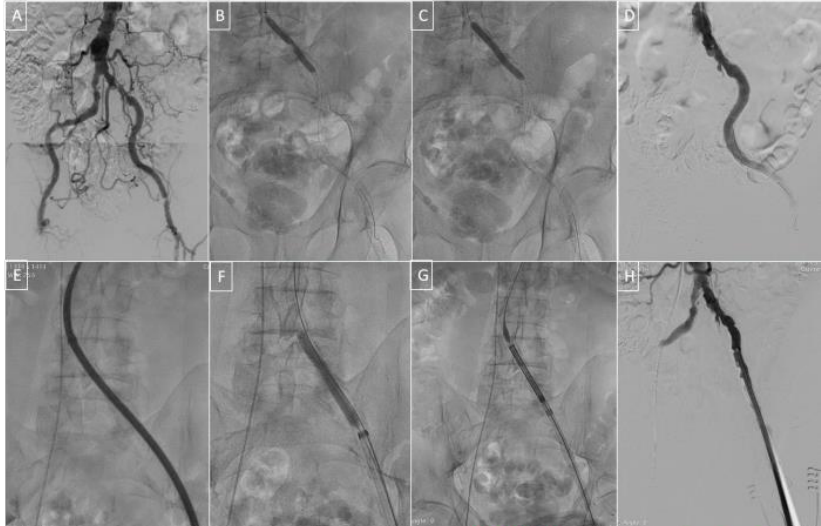
Figure 2. Intravascular lithotripsy (IVL) to facilitate TAVI (transcatheter aortic valve implantation) transfemoral access in a 79-years-old patient with severe aortic stenosis and end-stage chronic kidney disease on haemodialysis, arterial hypertension and diffuse peripheral arterial disease with claudication, previous renal artery stenting and severe carotid artery atherosclerosis. STS score: 7.5. Upper panels ( A – D ): severe occlusive calcific peripheral disease assessed by baseline aorto-iliac angiography ( A ); lesion preparation with IVL 6 × 60 mm Shockwave balloon on left common iliac artery inflated at 6 Atm with dog boning effect due to the severe calcification, 300 pulses delivered ( B , C ); intermediate result with greater lumen gain ( D ); lower panels ( E – H ): attempt to deliver a 14F sheath followed by further Shockwave 7 × 60 mm balloon inflation at 6 Atm (300 pulses) ( E , F ); the successful crossing of valve delivery system and final angiographic result showing absence of vessel rupture, dissection or perforation ( G , H